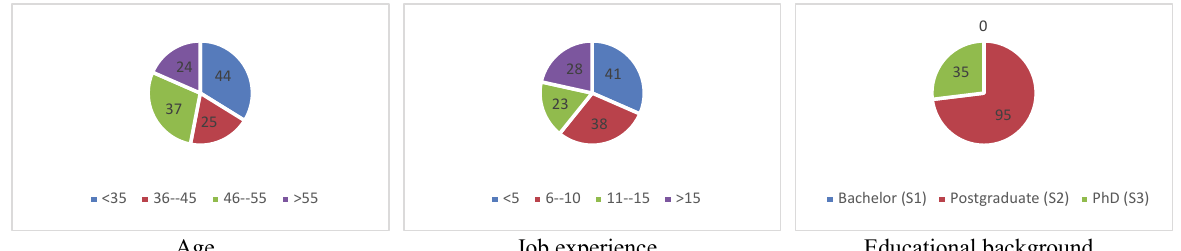
Fig. 1. Personal characteristics of the